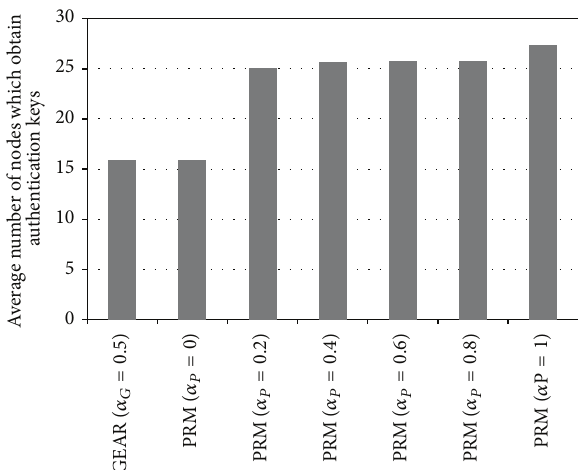
Figure 8: Average number of nodes that obtain authentication keys from a source cluster.